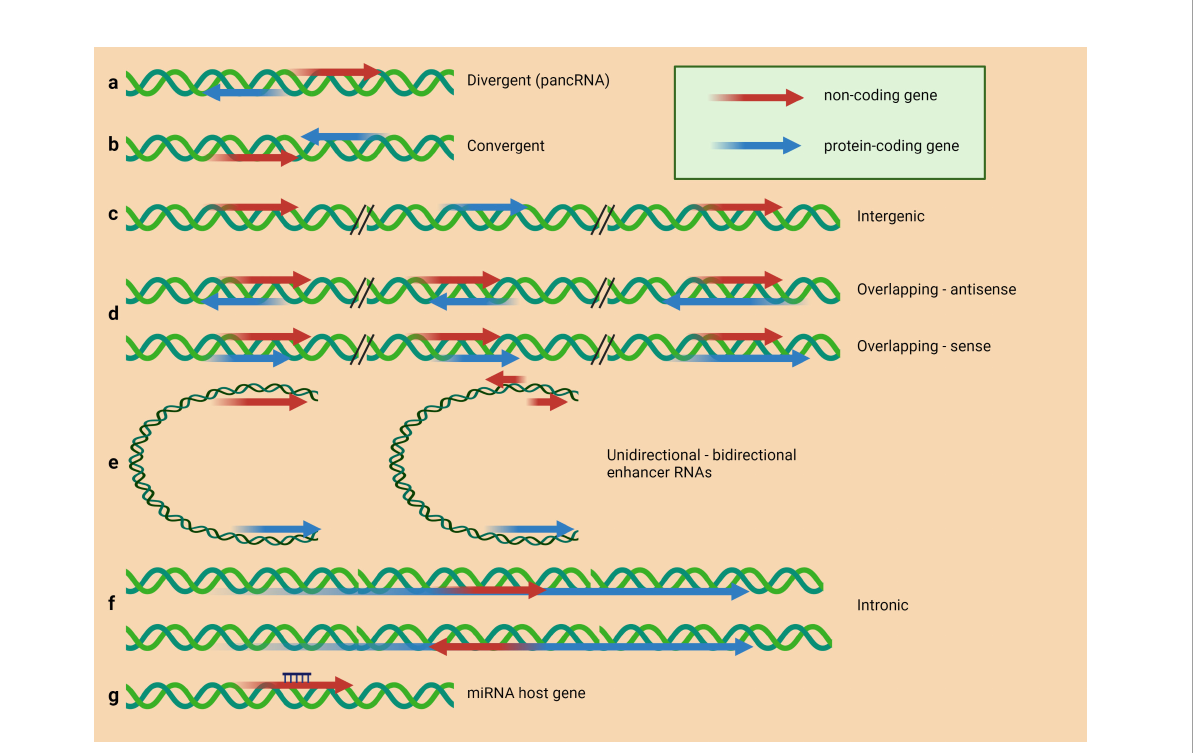
FIGURE 1 LncRNAs classi fi cation based on their structural origin. According to Schmitz et al. (35), lncRNAs can be classi fi ed in (A) divergently transcribed lncRNA originating from the same promoter region as the adjacent protein-coding gene, but from the opposite strand; (B) genes encoded on opposite strands, facing each other and convergently transcribed; (C) intergenic lncRNA (lincRNA) located distant from other genes; (D) lncRNAs overlapping with other genes on the same or opposite strand; (E) enhancer RNAs expressed as uni- or bidirectional transcripts; (F) lncRNA transcribed from an intron of another gene; (G) lncRNA hosting